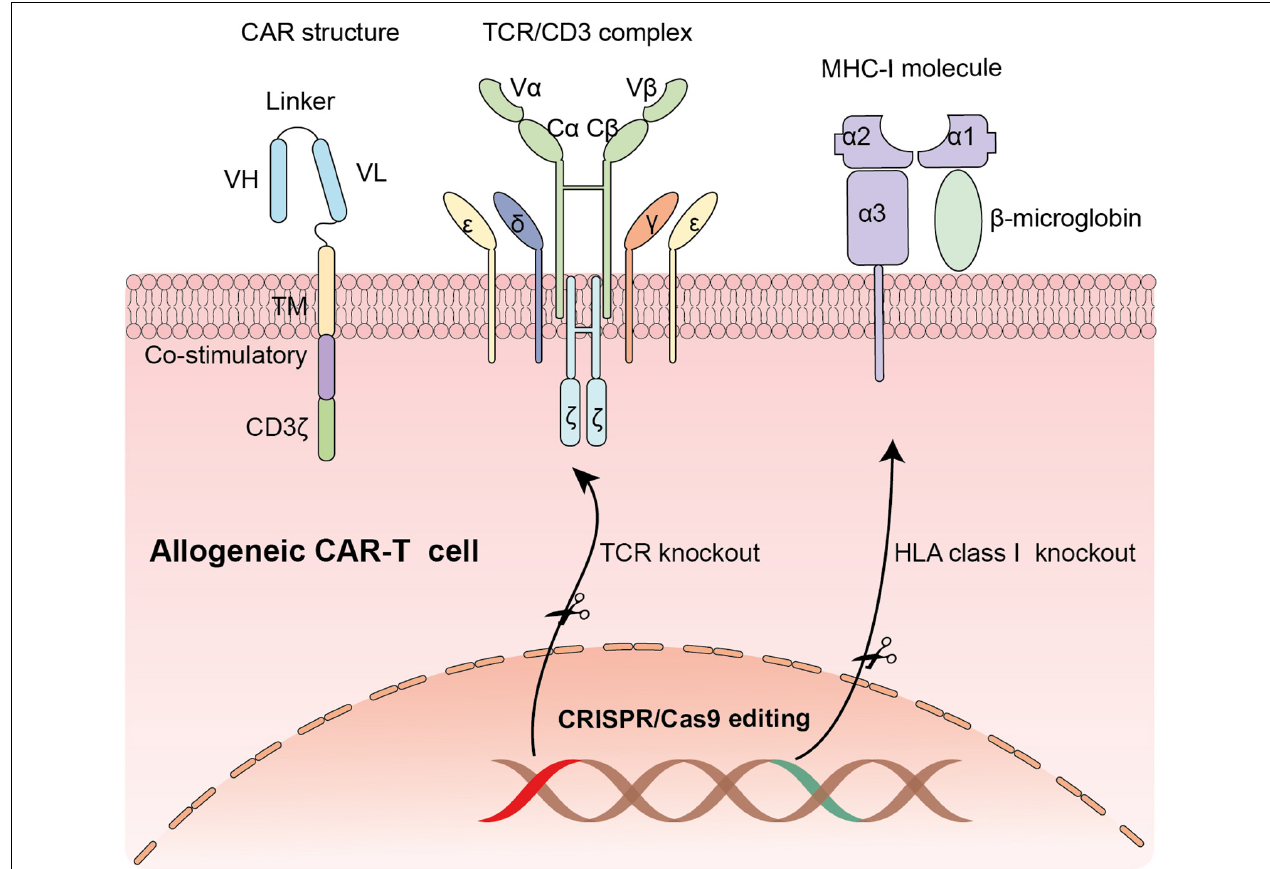
FIGURE 1 | The application of CRISPR/Cas9 system in editing CAR-T cells: Knocking out endogenous TCR locus and MHC-1 molecule to generate universal CAR-T cells.